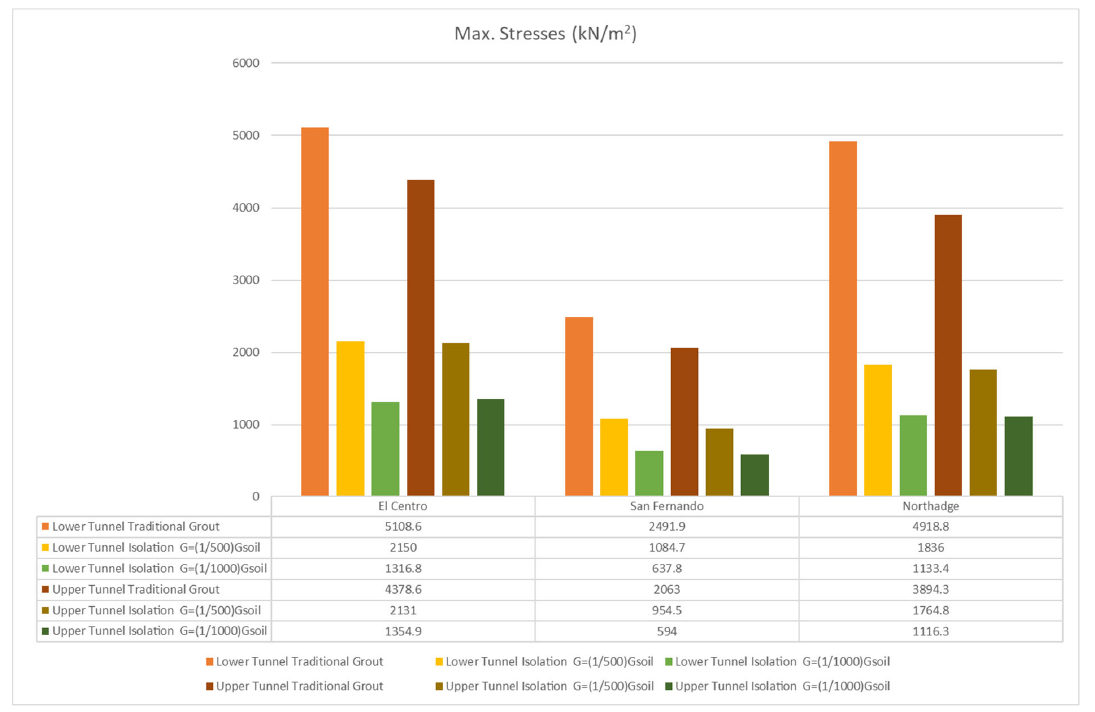
Infrastructures 2022 , 7 , x FOR PEER REVIEW Figure 11. Maximum transverse stresses of twin tunnels in stiff soil. Figure 11. Maximum transverse stresses of twin tunnels in stiff soil.